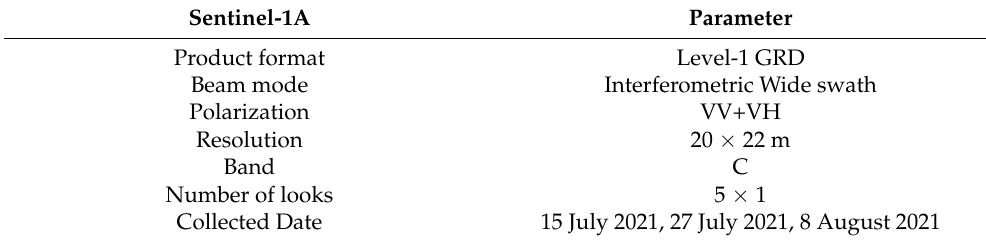
Table 2. Parameters of the Sentinel-1A SAR image used in the experiment.